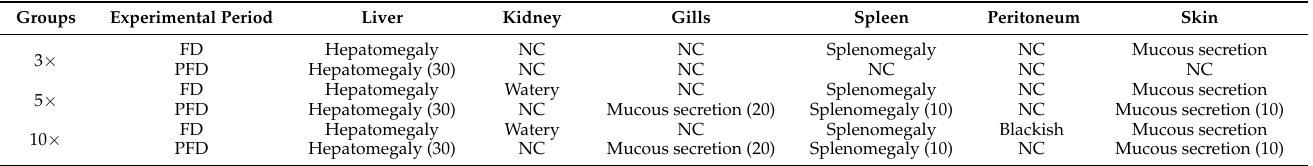
Table 1. Recorded abnormalities in Oreochromis niloticus juveniles after dietary florfenicol (FFC) ad- ministration at 1 – 10 times the therapeutic dose of 15 mg kg biomass −1 day −1 for 10 consecutive days in comparison to control.